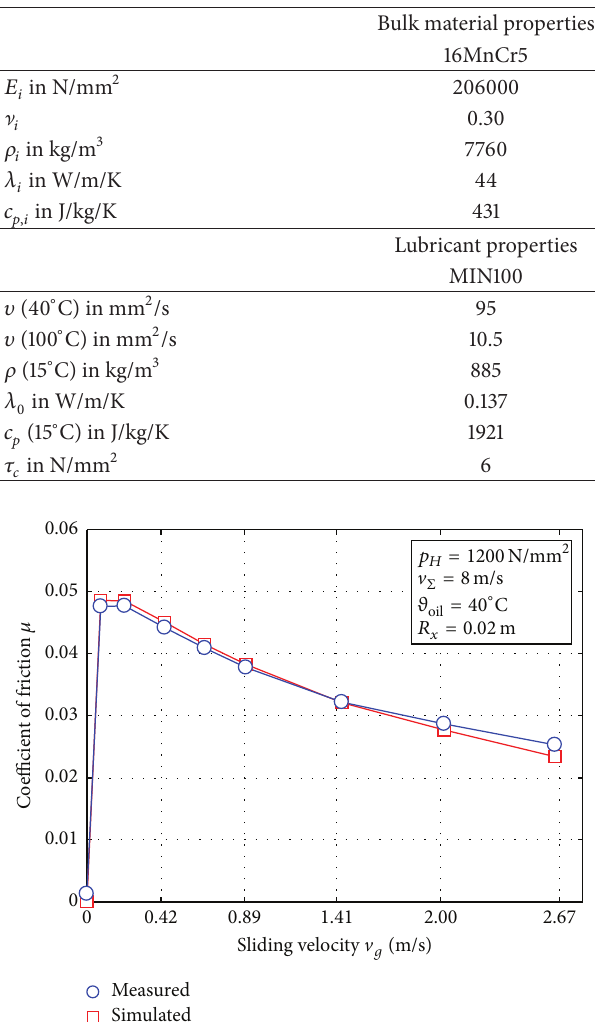
Table 1: Lubricant and bulk material properties ( 𝑖 = 1, 2 ).